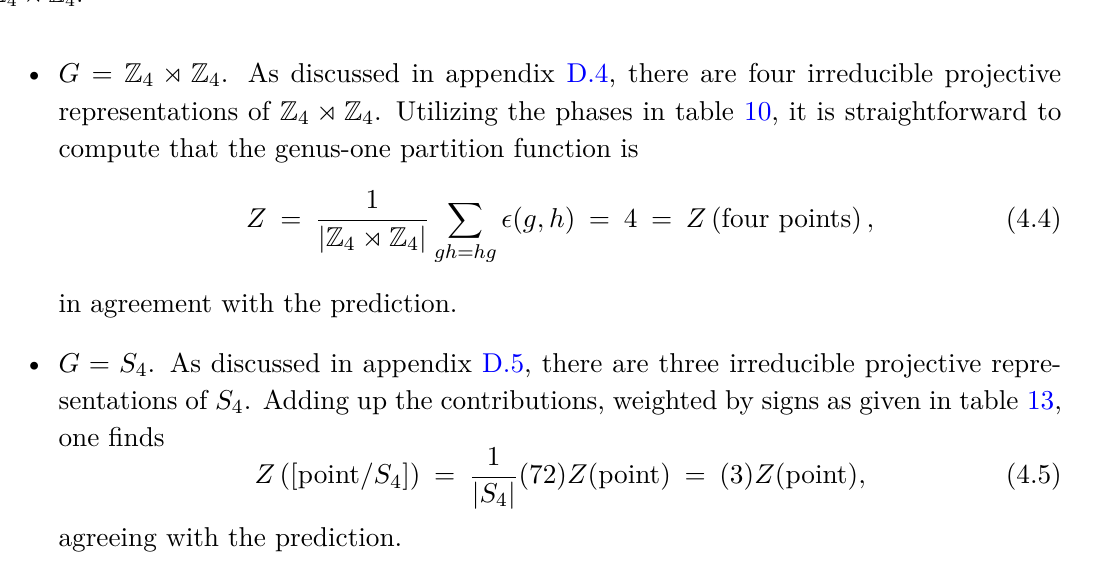
Table 1 . Cocycle for ι ∗ ω for ω the nontrivial element of H 2 ( Z 4 o Z 4 , U(1)) , and ι : Z 2 × Z 4 , → Z o Z 4 4